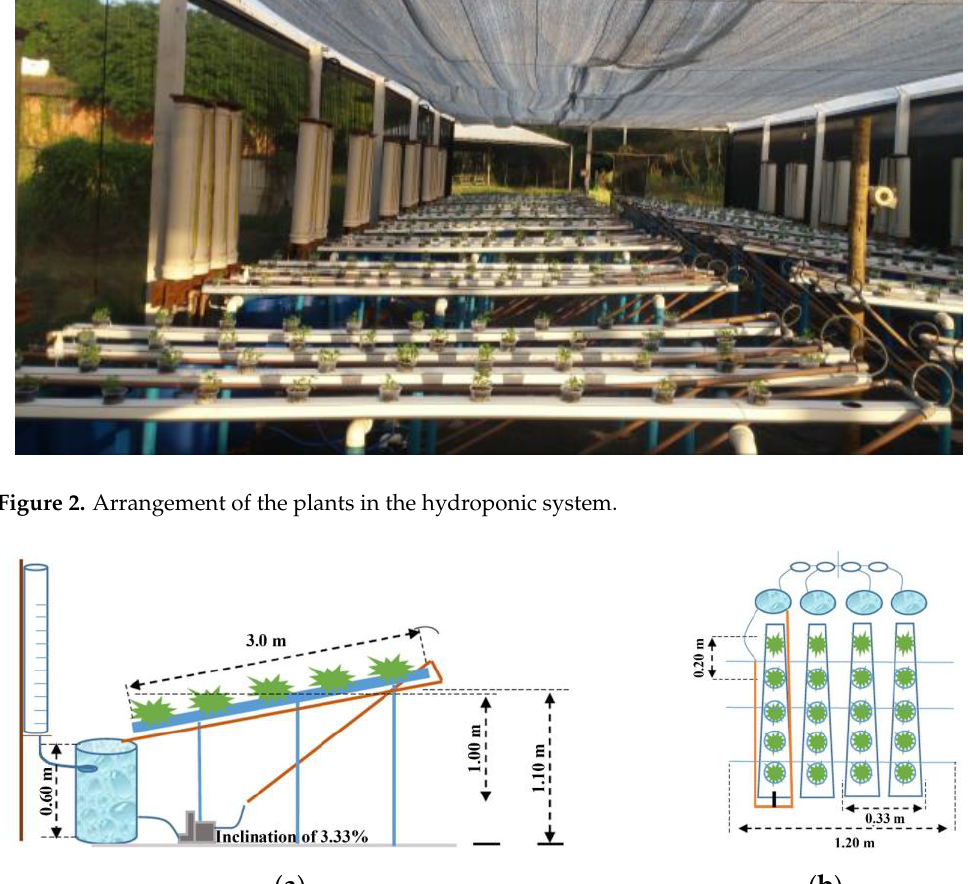
Figure 3. Side view ( a ) and top view ( b ) of the experimental plot.